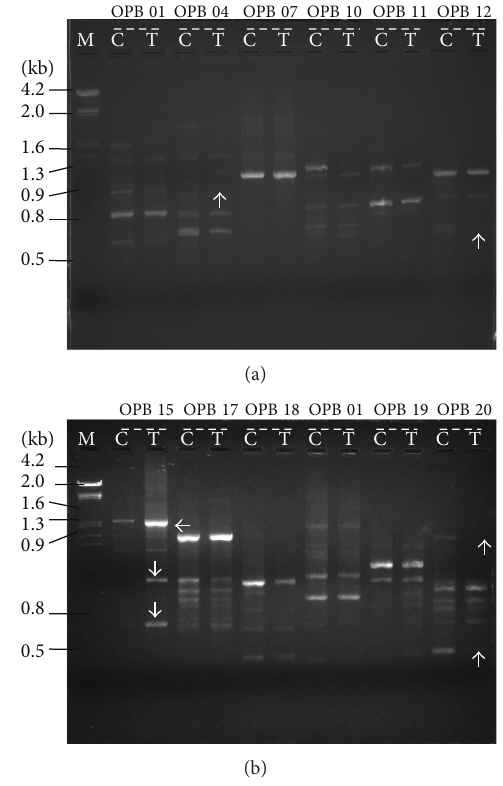
Figure 4: RAPD profiles of genomic DNA isolated from the leaves of Mentha arvensis seedlings after 12 days of Hg treatment along with control. Lane M: molecular marker; Lane C: control; Lane T: 25 mg/L Hg treatment; ↑ : disappearance of normal bands; ↓ : appearance of new bands; → : intensity of